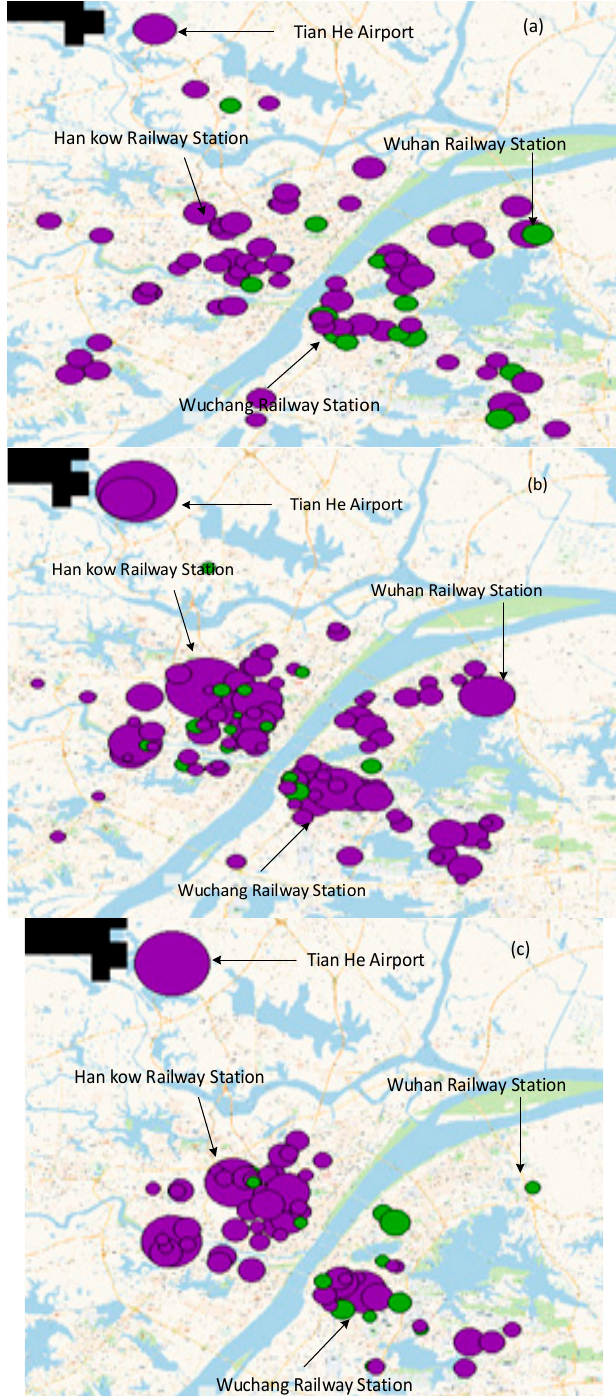
Figure 9. Stopping spots of the off-peak duration of high ( a ), moderate ( b ) and low ( c ) profitability drivers. As shown in Figure 9, colored pie charts represent the traffic congestion and parking clusters, where green pie charts represent congestions clusters, whereas purple pie charts are parking clusters. The size of each pie chart is proportional to the total number of elements in the cluster. Although